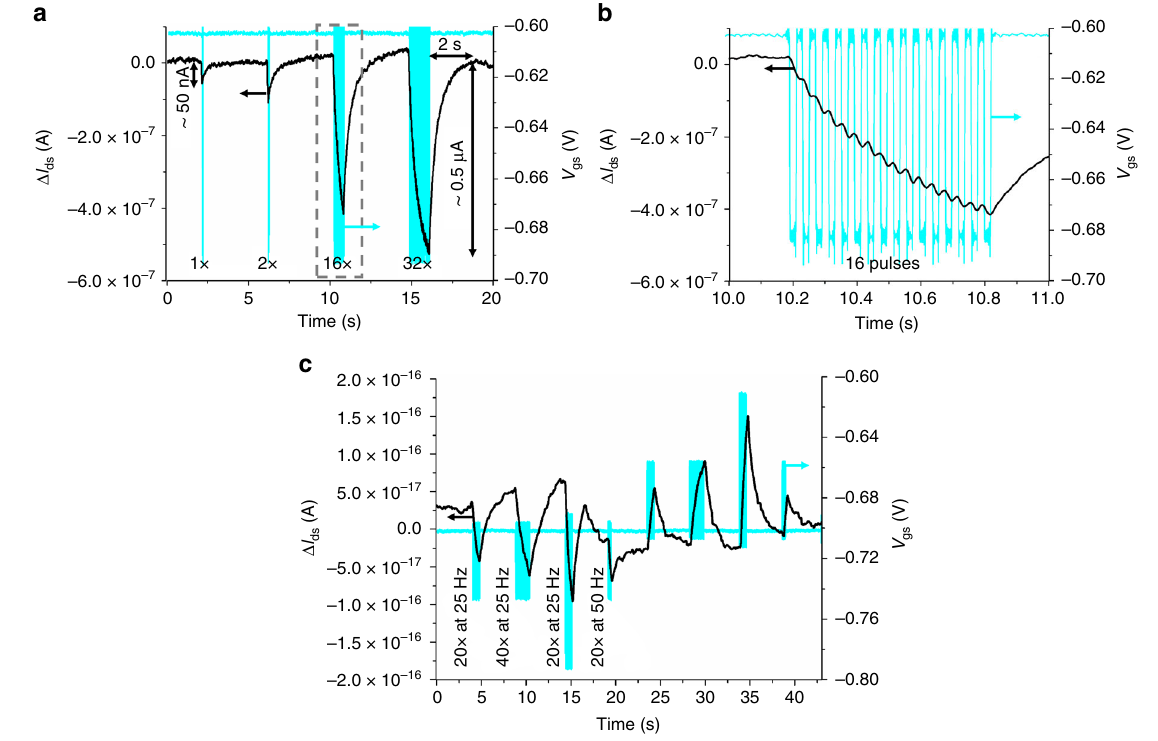
Fig. 4 Synaptic behavior of the inkjet (IJ)-printed stretchable fi eld effect transistors (FETs). a Source – drain current variation ( Δ I ds , on the left axis) response over time to small gate voltage pulses ( V gs , on the right axis) that imitates neuron presynaptic potential spikes for FETs with W / L = 1000 µ m/50 µ m. The pulses consist of a square signal of − 80 mV of amplitude (on top of an initial biasing voltage of − 0.6 V applied for long enough time to ensure the full formation of the channel), 25 Hz of frequency, and duty cycle of 50%. The drain – source voltage was held at − 1.1 V. The source – drain current response is tested for consecutive trains of 1, 2, 16 (magni fi ed in b ) and 32 gate voltage pulses, displaying typical postsynaptic current variation that increases with the number of pulses and relaxes in their absence (the higher the number of pulses, the longer the relaxation time). b Zoom-in on the part of the signal delimited by the dashed box in a . The ripple in Δ I ds observed for each individual pulse of only − 80 mV highlights the good voltage resolution of the devices. c Source – drain current variation ( Δ I ds , on the left axis) over time for the same devices when voltage pulse trains are applied to the gate. The pulse trains have a duty cycle of 50% and are inputted in such a way that each train differs from the fi rst one (control) in either: (1) number of pulses (40 pulses for the 2nd train vs. 20 for the control), (2) amplitude ( − 80 mV for 3rd train vs. − 40 mV for control), or (3) frequency (50 Hz for the 4th train vs. 25 HZ for control). The source – drain current responds to all three factors in agreement with short-term synaptic plasticity, that is, the higher the number of pulses, their amplitude and their period, the higher the produced current variation and the longer the time needed for the devices to relax back to equilibrium.